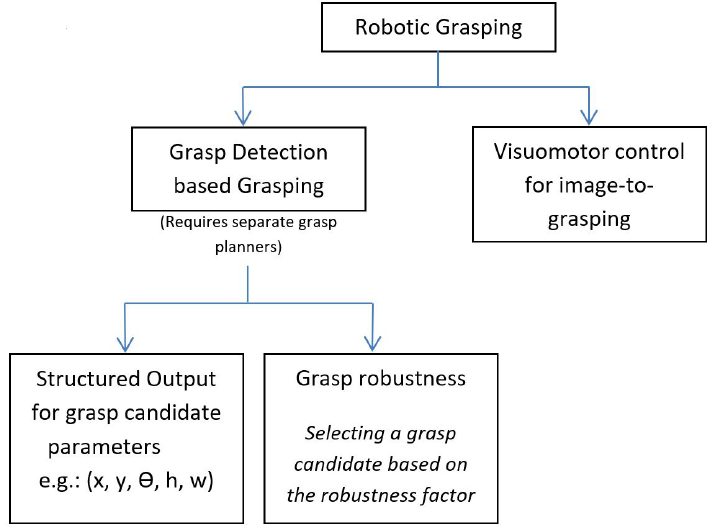
Figure 3. Categorisation of robotic grasping and grasp